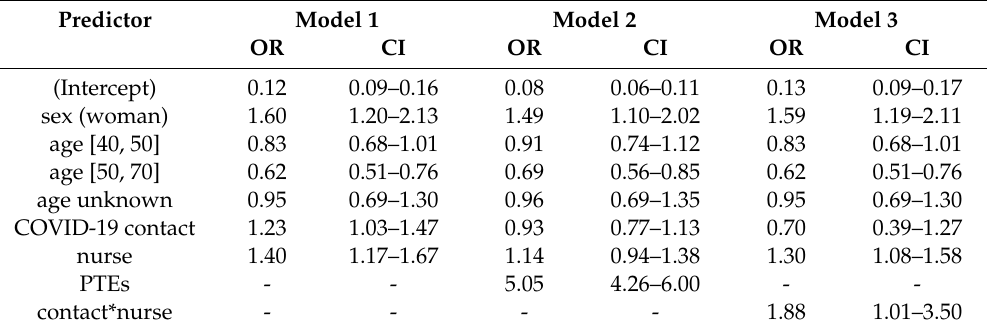
Table 4. Logistic regression models on the relation of sex, age, COVID-19 patient contact, potentially traumatic events (PTEs), and working as nurse and positive MHI-5 (N models 1 & 3 = 4672, N model 2 = 4531). (OR = odds ratio; CI = 95% confidence interval) 1 .